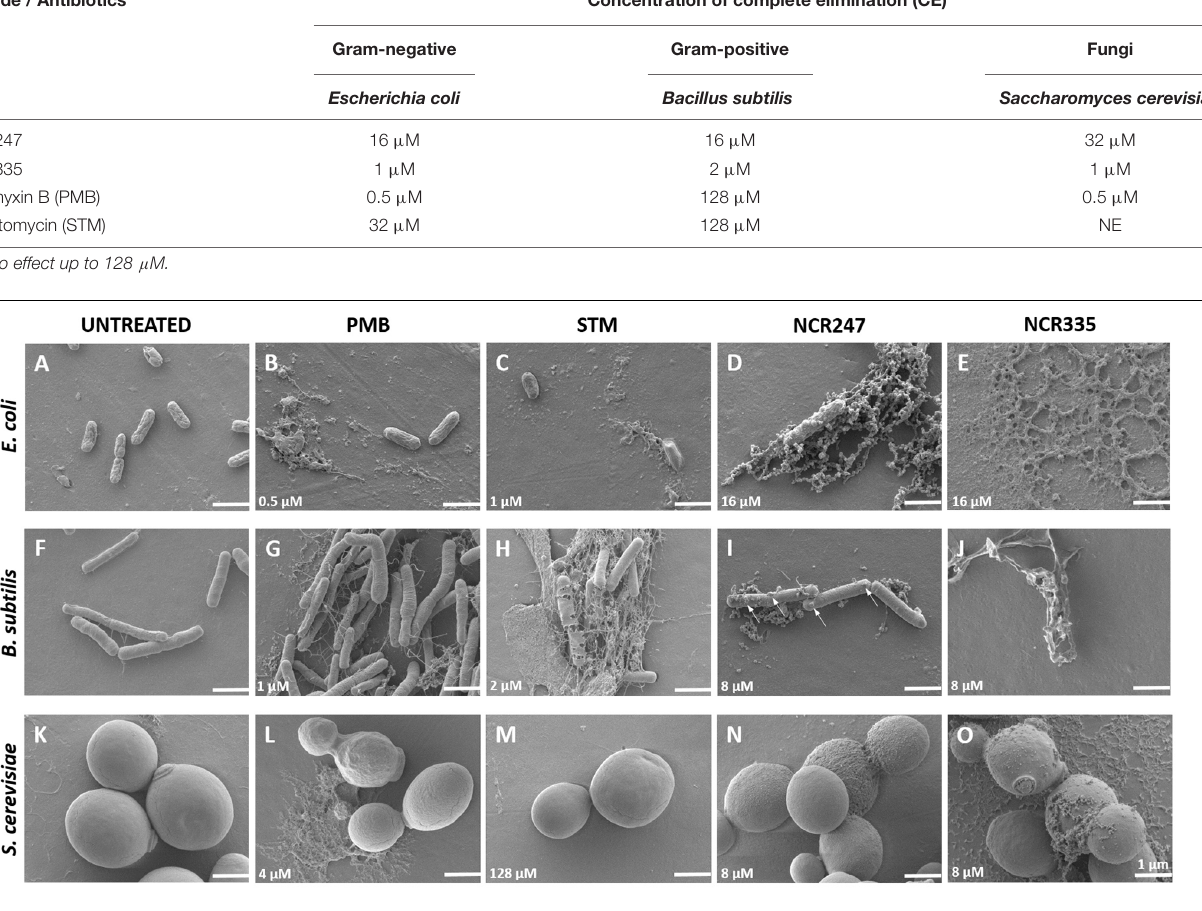
FIGURE 1 | Morphology of control (untreated) and peptide/antibiotics treated E. coli , B. subtilis and S. cerevisiae at MICs observed with Scanning Electron Microscopy. All treatments were made in LSM at minimal inhibitory concentration (MIC) shown in the lower left corner of each panel. The arrows (panel I ) indicate the observed blebs and blisters. Scale bar: 1